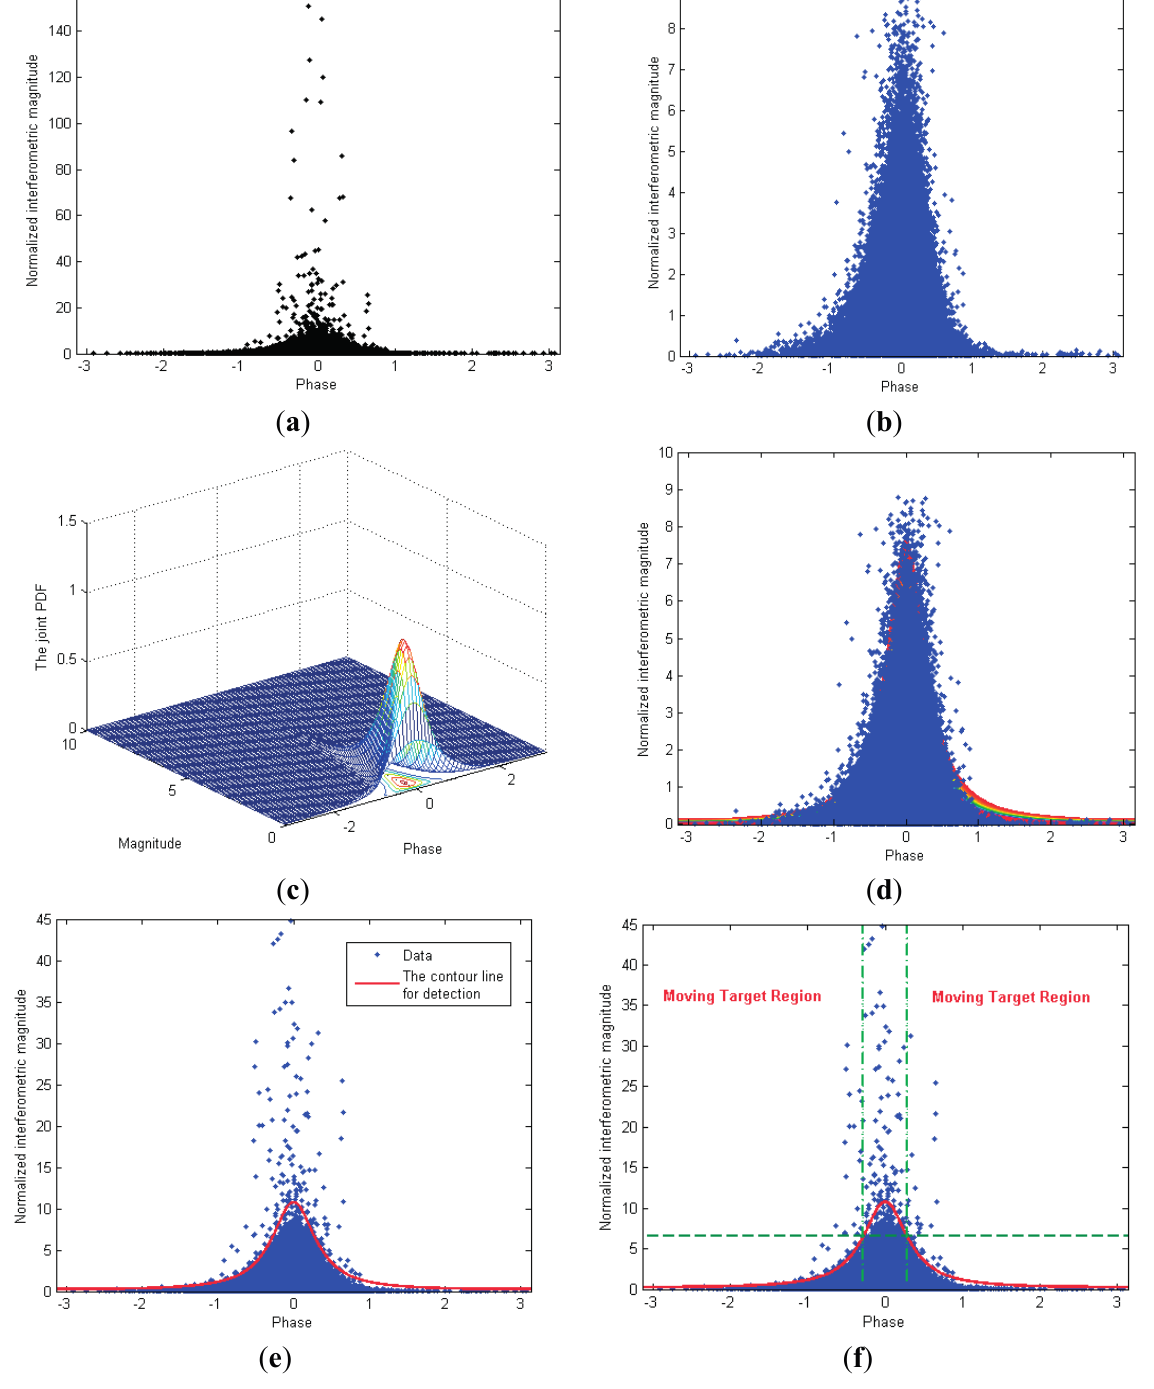
Figure 7. Detection in the M-P plane of the measured SAR data: ( a ) Magnitude vs. phase of the measured SAR complex signals; ( b ) The remaining censored clutter points in the M-P plane; ( c ) The theoretical PDF calculated to fit the 2-D histogram of the censored clutter; ( d ) The overlap display between the censored clutter and the M-P plane projection of (c, e ). The obtained contour line for detection (Note: the vertical axis is plotted in a smaller range in contrast with (a) for better visualization); ( f ) The locked regions of moving targets by T p , T m as well as T CFAR (Note: the vertical axis is plotted in a smaller range in contrast with (a) for better